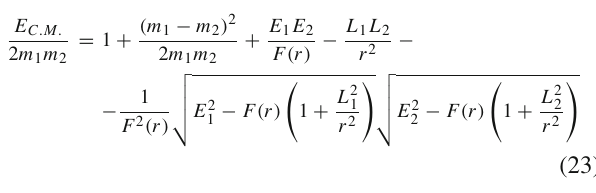
Fig. 8 Center-mass energy for L 1 , L 2 and λ different